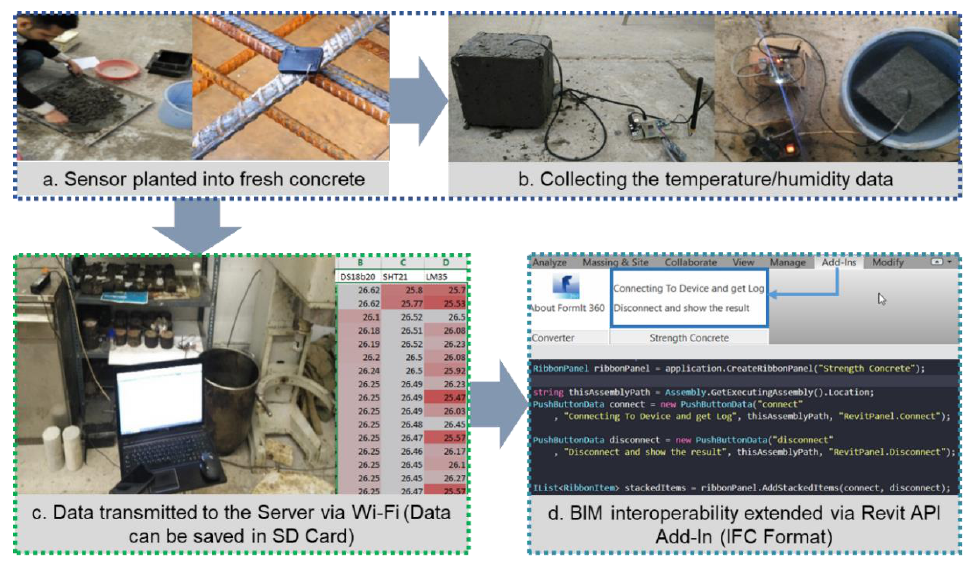
Figure 4. Process to link building information modeling (BIM) and sensors planted in concrete.